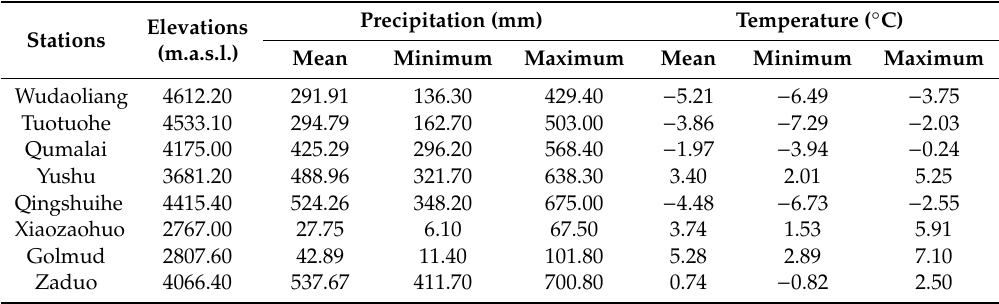
Figure 2. Areal mean annual precipitation and temperature in Zhimenda ( a ) and Tuotuohe ( b ) sub-basins. Table 1. Observation stations with mean, minimum, and maximum annual precipitation and temperature during